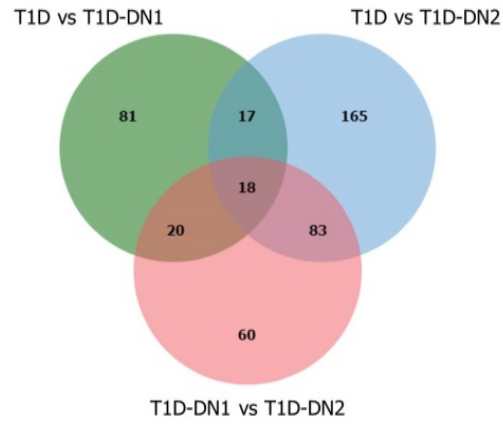
Figure 1. The Venn diagram of the metabolite m / z features values significantly differed between T1D and T1D ‐ DN1 (green), between T1D ‐ DN1 and T1D ‐ DN2 (red), as well as between T1D and T1D ‐ DN2 (blue).